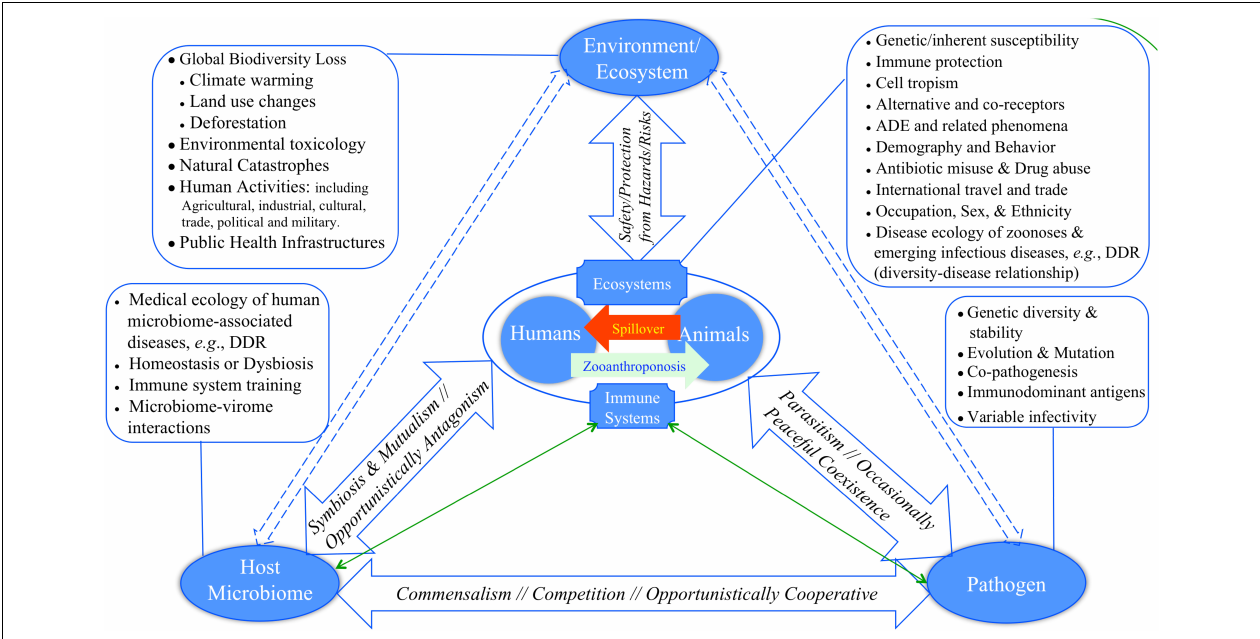
FIGURE 1 | Revised FMB (Fauci-Morens-Bernardo-Cravo) pyramid model of human diseases for describing the four-way interactions between host, host microbiome, pathogen, and environment (Fauci and Morens, 2012; Bernardo-Cravo et al., 2020; Morens and Fauci, 2020): ( i ) The relationship between host and his or her microbiome may not be monotonically competitive; for example, host microbiome can be refuge camps for opportunistic pathogens, and the microbiome may lose suppressive effects to opportunistic pathogen when itself enters alternative dysbiosis states. ( ii ) Similarly, the relationship between host and host microbiome can be complicated, could even be frenemy relationship; for example, diseases such as BV (bacterial vaginosis) may be caused by the dysbiosis of vaginal microbiome, and there may not be a formally identified BV pathogen. On the other hand, host physiology and immunology can significant impact the ecology and physiology of microbiomes, and therefore their relationship are bidirectional. In fact, the triangle relationship in the floor of the pyramid should by cyclic, and perhaps the cyclic nature is a norm in all facets of the